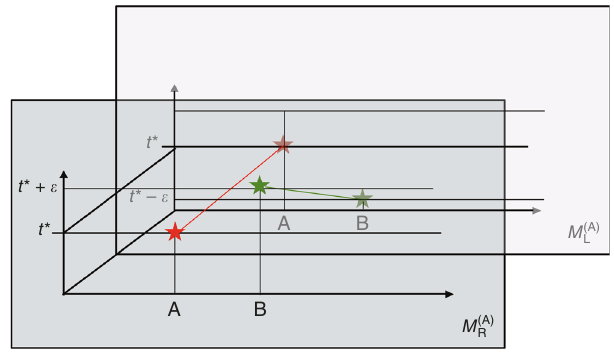
Fig. 6 The gravitational switch thought experiment as described in the time reference frame of A (local observer). The event in which A acts on S is depicted by a red star. This event is perfectly localised in time from A ’ s point of view. However, as in the previous case, in the spacetime M ð A Þ R ( M ð A Þ ), the mass M is on the right (left), implying that A acts before (after) Fig. 5 Space-time diagram for gravitational switch thought experiment as L B. The causal order is conserved, for each spacetime amplitude, after the described in the time reference frame of C. The event in which A (B) acts on S is depicted by a red (green) star. These events are delocalised in time change of perspective. In both M ð A Þ and M ð A Þ , A ’ s action happens at time R L t *, whereas B acts at t */ Δ R (B, A) ≈ t * + ϵ (resp. t */ Δ L (B, A) ≈ t * − ϵ ) in from C ’ s point of view. In the spacetime M ð C Þ ( M ð C Þ ), the mass M is on the R L right (left), implying that A acts before (after) B. (For clarity, the worldline M ð A Þ R ( M ð A Þ L ), for ϵ ¼ ð Φ L (cid:5) Φ L Þ = t (cid:4) . Note that the dashed red line joining B A of M is not shown.) In M ð C Þ A ’ s event in both spacetimes is now parallel to the dashed black line joining ( M ð C Þ ), A ’ s action happens at time t */ Δ R R L t * in both spacetimes. This means that we are in the time reference frame (A, C) ≈ t * − δ (resp. t */ Δ L (A, C) ≈ t * + δ ) and B ’ s action happens at t */ Δ R where the event happens at a precise, sharp time. In contrast, the dashed (B, C) ≈ t * + δ (resp. t */ Δ L (B, C) ≈ t * − δ ), for δ ¼ ð Φ L (cid:5) Φ L Þ = t (cid:4) . The C A green line joining B ’ s event in both spacetimes is not parallel to the black dashed red (green) line joining A ’ s (B ’ s) event in both spacetimes is drawn dashed one, showing that the time localisation of B ’ s event is not sharp in to emphasise that this is the same event, even though we have used two A ’ s time reference frame. red (green) stars, one per spacetime, to depict it. NATURE COMMUNICATIONS| (2020) 11:2672